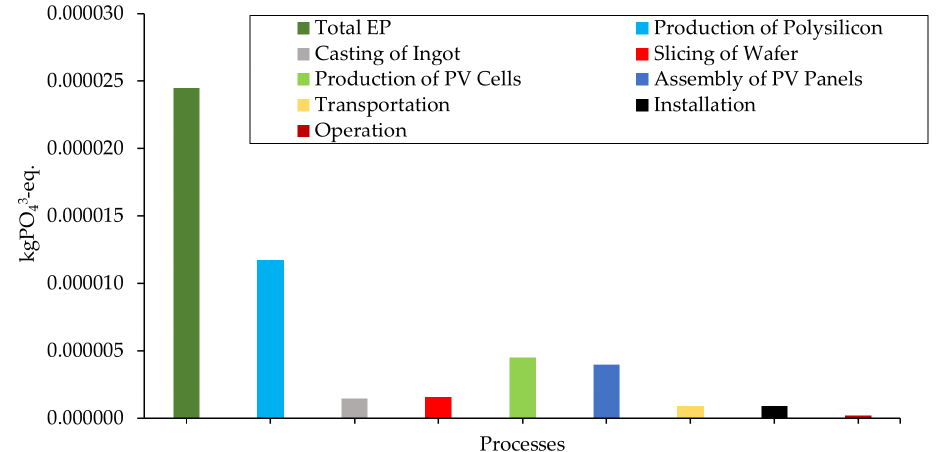
Figure 8. Eutrophication potential.